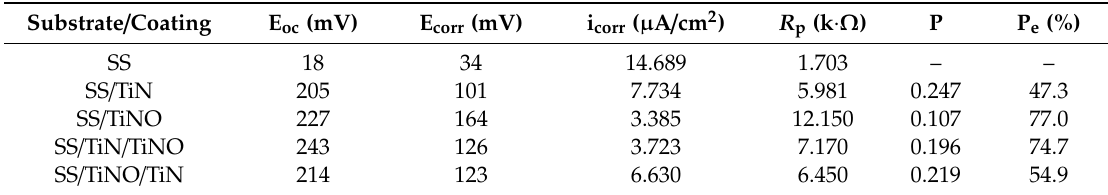
Table 3. Corrosion parameters of studied samples in 0.10 M NaCl + 1.96 M H 2 O 2 at 37 ± 0.5 ◦ C: E oc : open circuit potential; E corr : corrosion potential; i corr : corrosion current density; R p : polarization resistance; P: porosity; P e : protective e ffi ciency.